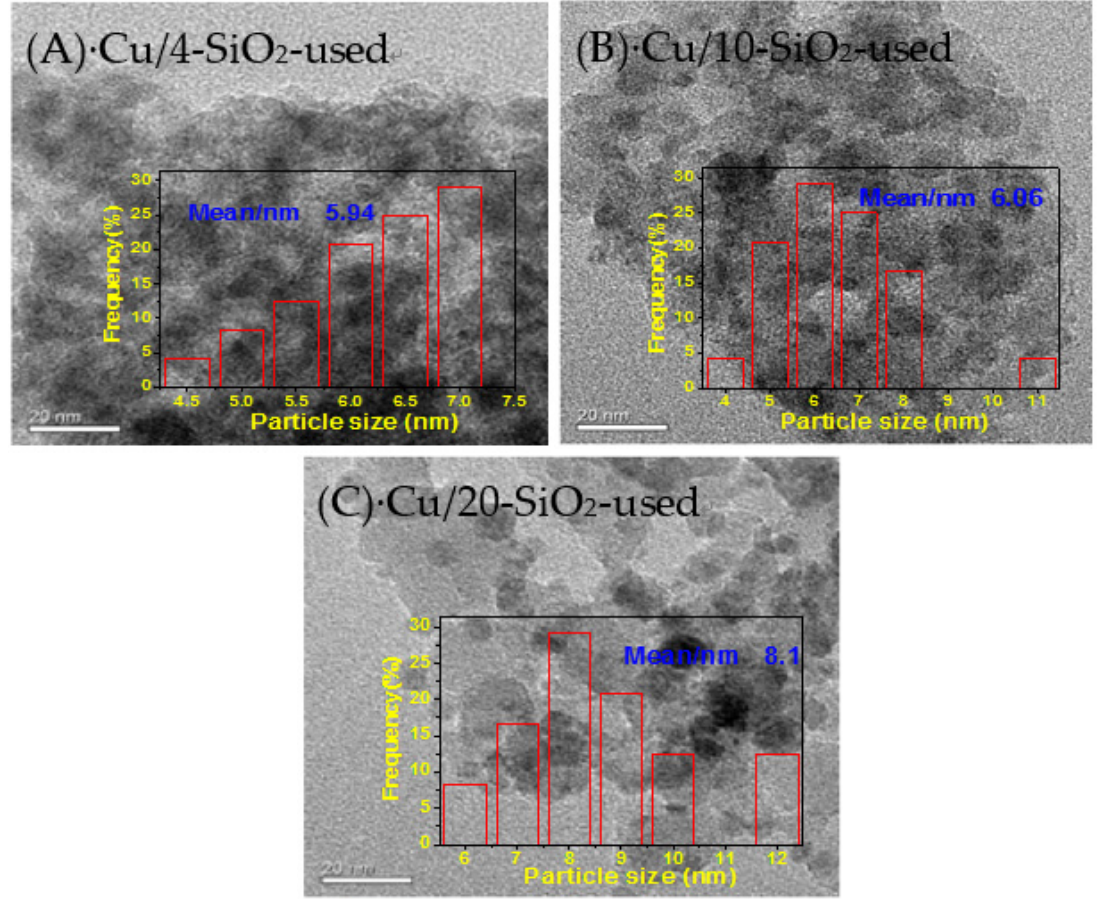
Figure 8. TEM images of used catalysts. ( A ) Cu/4-SiO 2 -used; ( B ) Cu/10-SiO 2 -used; ( C ) Cu/20-SiO 2 -used.